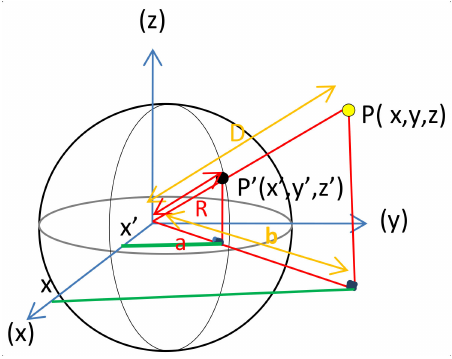
Figure 2. Schema of the geometry of a spherical projection.